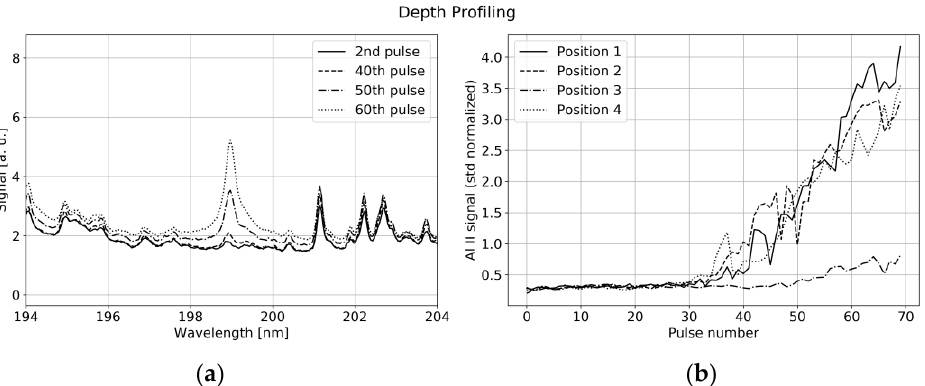
Figure 12. ( a ) VUV spectrum around a prominent Al II ionic line for subsequent laser pulses at the same position with 6 mJ pulse energy. ( b ) Signal of Al II ionic line for subsequent laser pulses at four different points along a line.